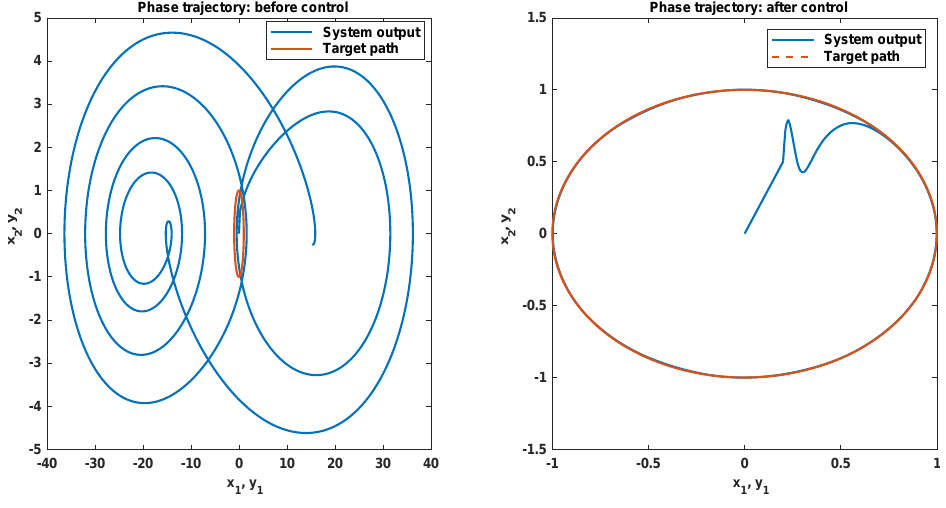
Figure 8. Example 1: phase trajectory, after and before control.